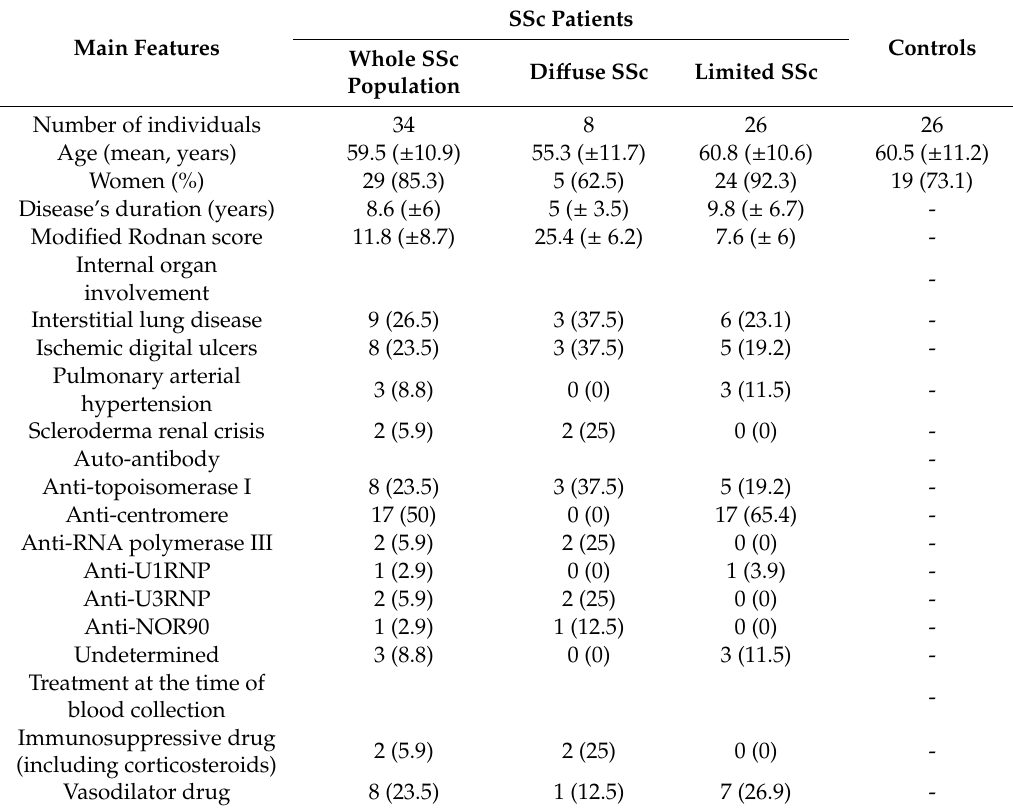
Table 1. Main features of systemic sclerosis (SSc) patients and